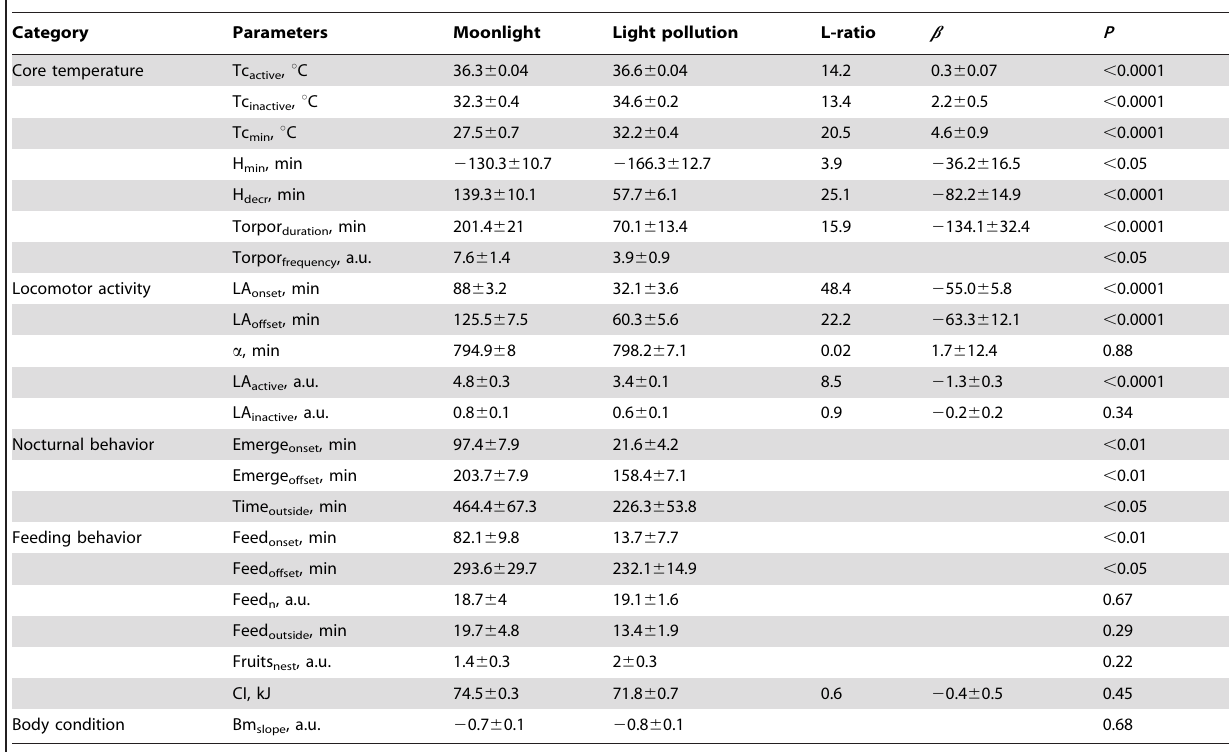
Table 1. Means 6 SEM of parameters and related